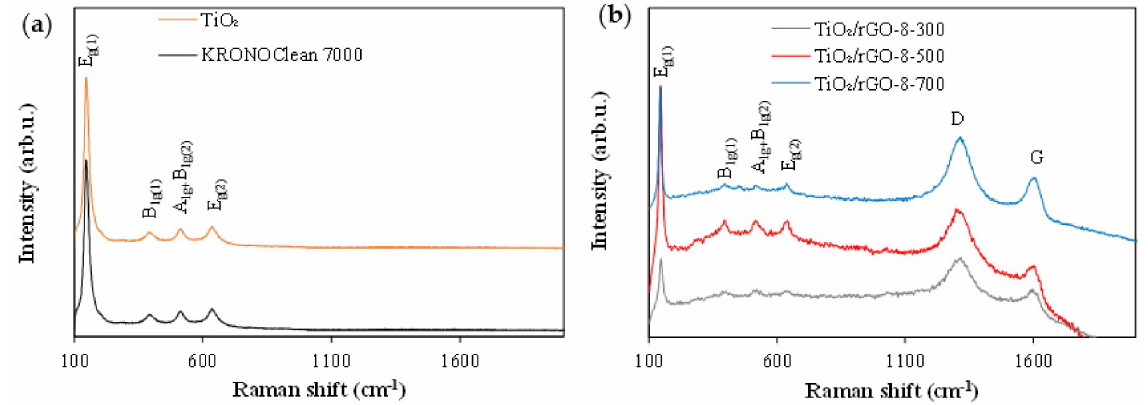
Figure 5. Raman spectra of ( a ) reference, control, and ( b ) exemplary obtained